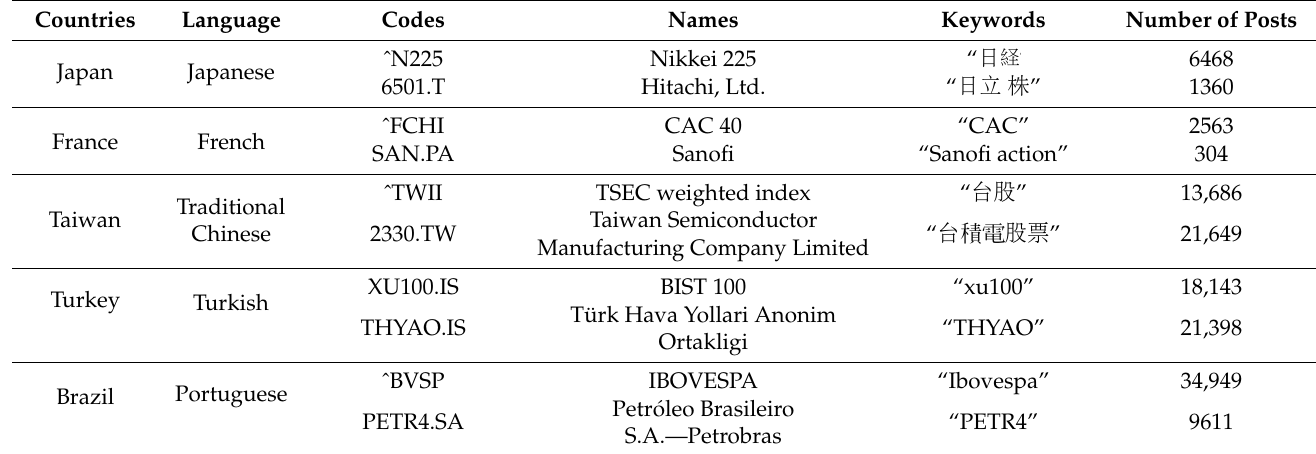
Table 2. The codes, keywords, and names of stock markets and corporations.